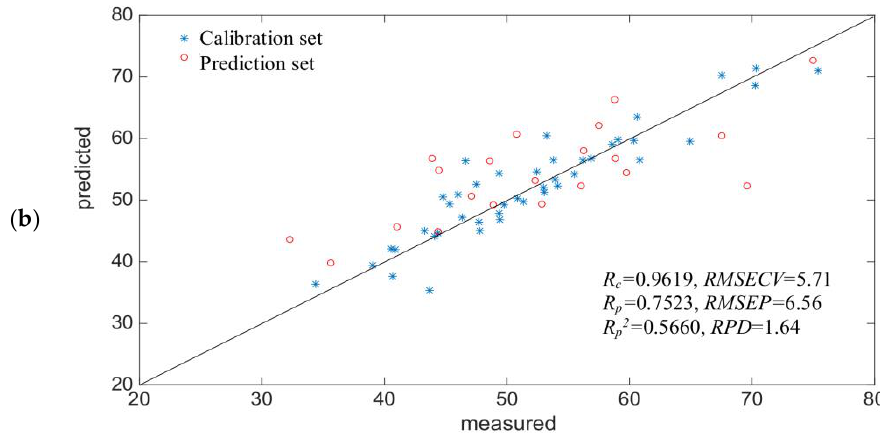
Figure 5. Reference measured versus NIR predicted value of BP-ANN model ( a ) SH content ( b ) SS content.